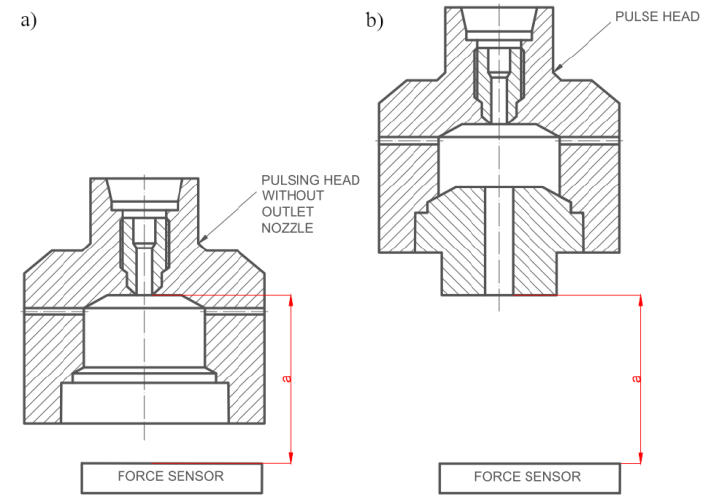
Figure 8. Graphical interpretation of the distance between the pulse head and the force sensor: ( a ) for a continuous stream, ( b ) for a pulsed stream.